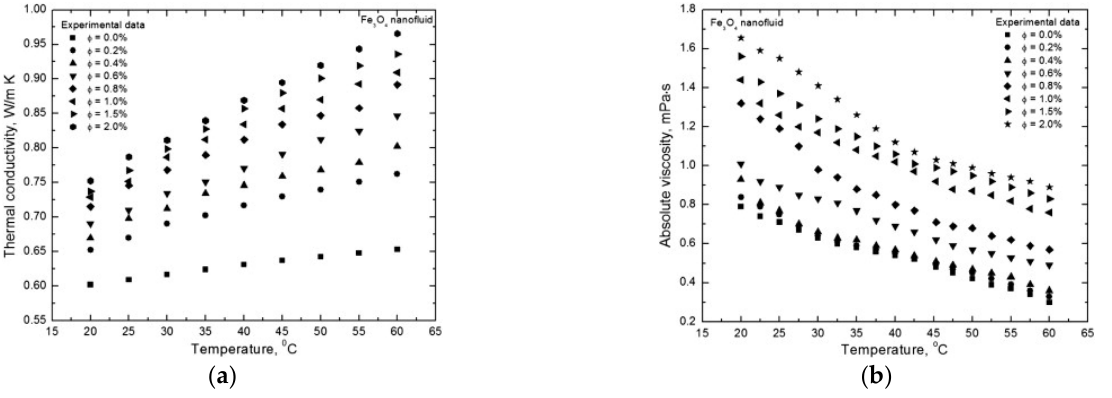
Figure 2. Typical behavior of ( a ) thermal conductivity and ( b ) viscosity as a function of nanoparticle volumetric fraction at various temperatures [39].